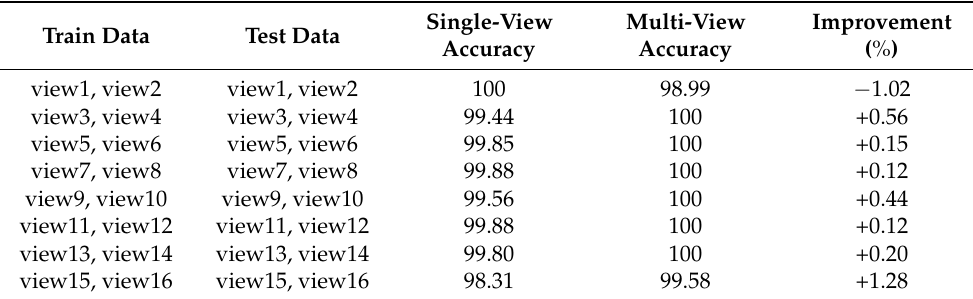
Table 7. State-of-the-art model [50] accuracy of single-view and multi-view learning on our UJM- TIV